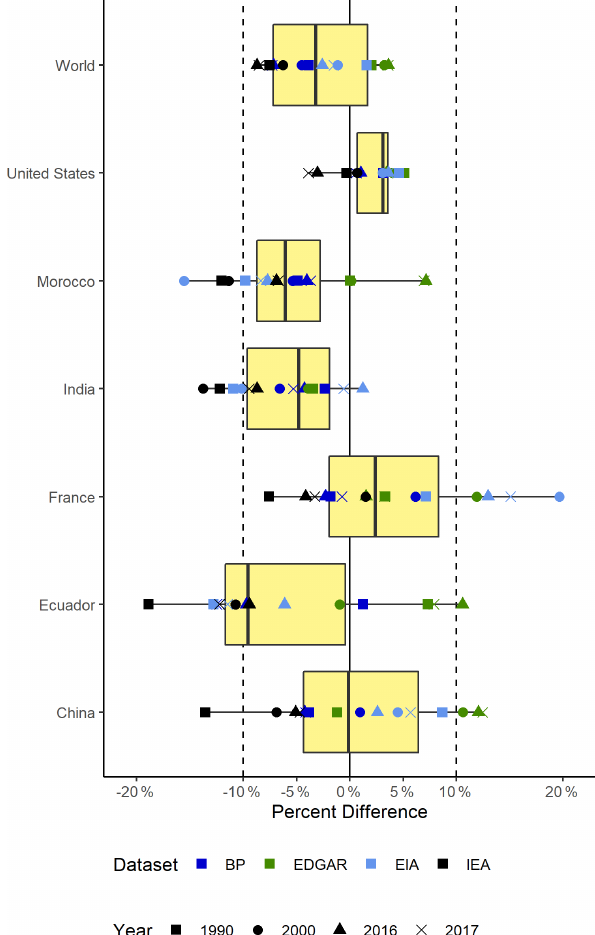
Figure 3. Comparison of four other global emissions datasets with CDIAC-FF for 1990, 2000, 2016, and 2017. Specific emissions datasets are cited in Sect. 2.1. The 0% centerline represents exact agreement with the CDIAC-FF value. Six countries and the global totals were selected to illustrate the variability between datasets and countries. Shapes represent each of the years, and colors represent each of the datasets. Box plots are used to show the general distri- bution of the percent difference, with the dark line in the box rep- resenting the median percent difference, the box representing the range of the 25th and 75th percentiles, and the whiskers represent- ing the overall range of the data. This demonstrates that with few exceptions the estimations are all within 10% of CDIAC-FF esti- mates for the selected countries and